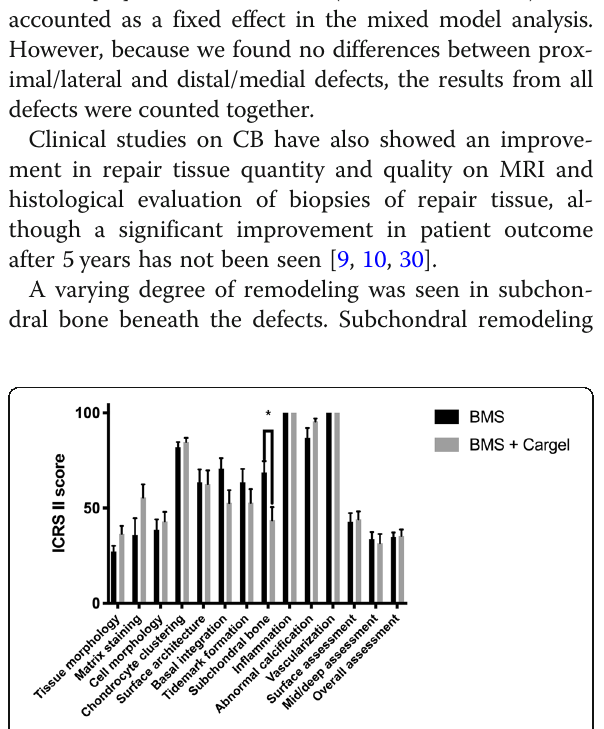
Fig. 5 Mean International Cartilage Repair Society (ICRS) II scores (+ standard error of mean (SEM)). n = 11 for each group. Higher scores indicate better tissue. BMS = bone marrow stimulation. Grey bar = CARGEL Bioscaffold + BMS, black bar = BMS only. * = p <